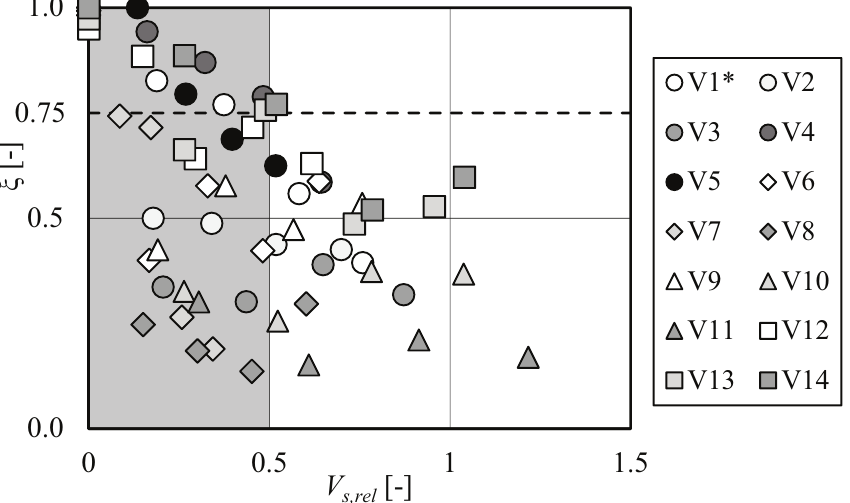
Figure 14. Bedload transport reduction factor ξ versus V s , rel for all tests. Circles correspond to different LW density, diamonds to LW size, triangles to fine material, and squares to LW shapes including